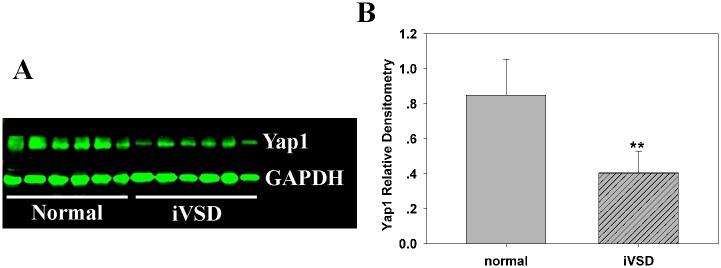
YAP1 protein expression is decreased in atrial tissue derived from iVSD patients.(A)Western blot analysis of resolved atrial tissues from control and iVSD hearts demonstrates that YAP1 is significantly decreased in iVSD hearts. (B) Numeric data obtained by densitometry analysis using GAPDH as a loading control. Data presented as means ± SDs. Student’s t-tests were performed to evaluate statistical significance (iVSD group: n = 20; control group: n = 6); **p < 0.01.